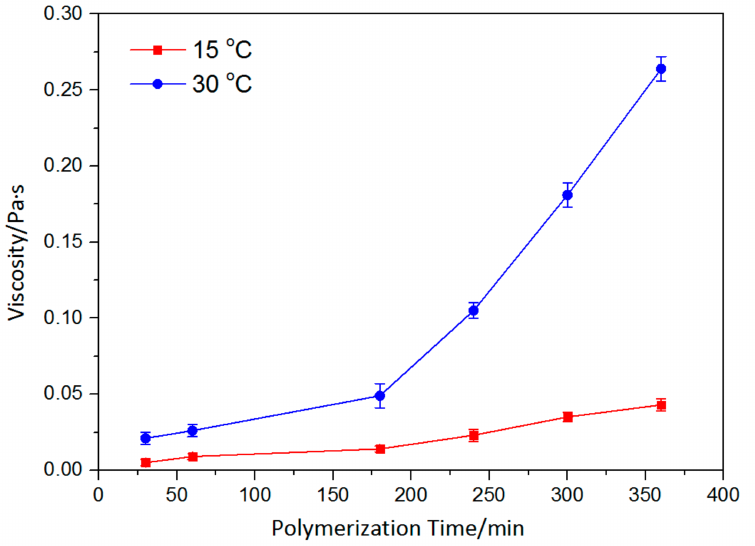
Figure 6. Viscosity of p (ASF-AGE-NIPAAm) spinning solution with different polymerization times at 15 and 30 ◦